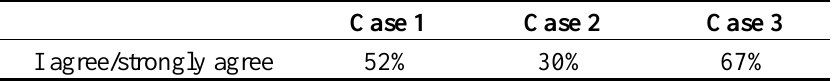
Table 5. Reflective practice changes